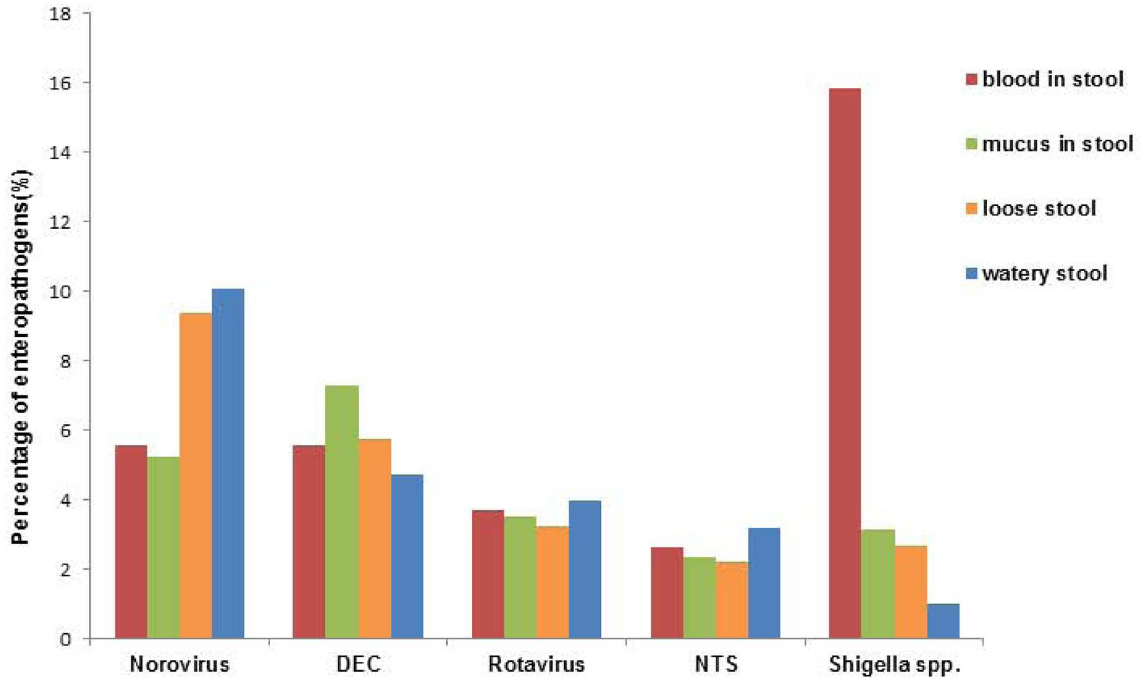
Fig 1. Positive proportion of predominant enteropathogens by stool type, 2009–2014. DEC = Diarrhea-genic Escherichia coli; NTS = Non-typhoidal Salmonella spp.